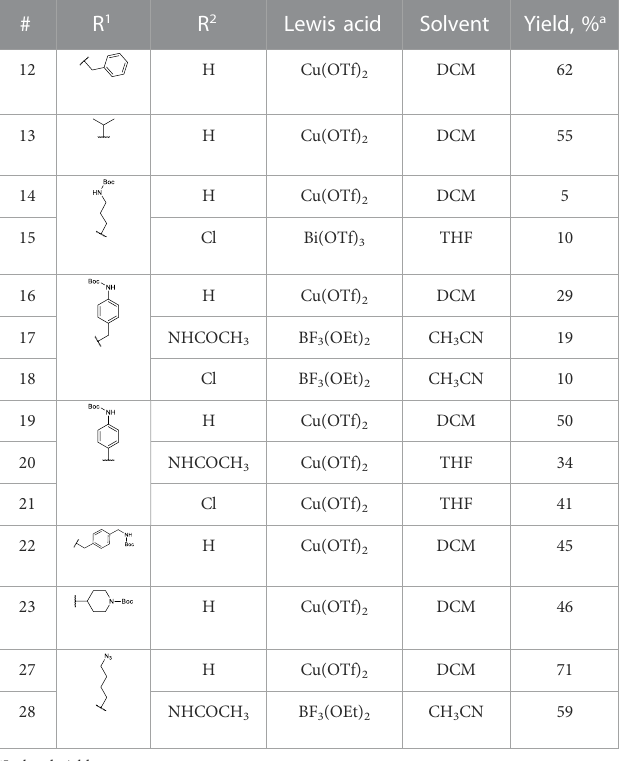
TABLE 1 Birum-Oleksyszyn reaction